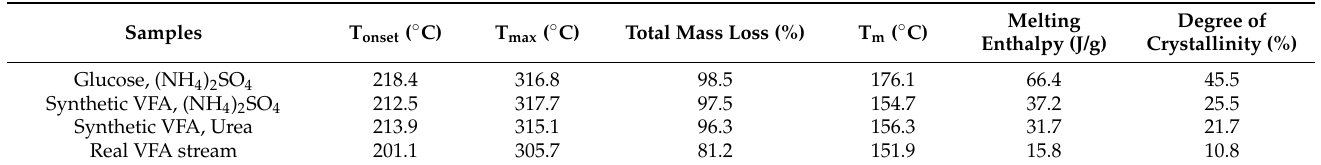
Table 4. Thermal characteristics of extracted polyhydroxyalkanoate (PHA) obtained from C. necator DSM 545 using different carbon and nitrogen